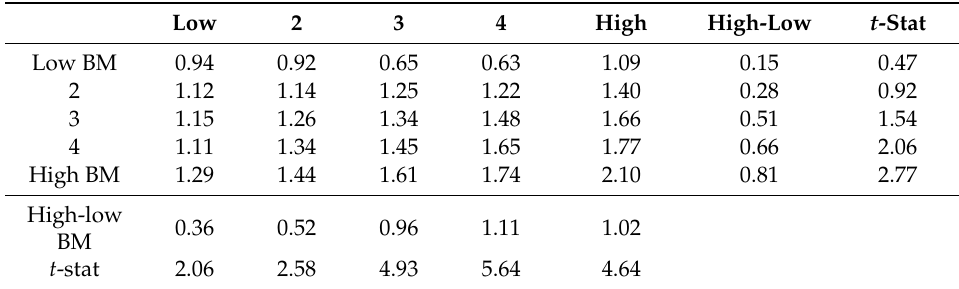
Table 12. Average returns from double-sorted quantile portfolios (sorted by book-to-market ratio and Merton’s default probability). From the data for July 1963 to December 2013, at the end of each month, stocks are independently sorted into 5 × 5 portfolios based on the book-to-market ratio and Merton’s default probability. The table shows average returns for each of 25 portfolios. Small-big is the return di ff erential between the small and big firm portfolios within each default quantile. High-low is the return di ff erential between the high and low default probability firms within each size quantile.